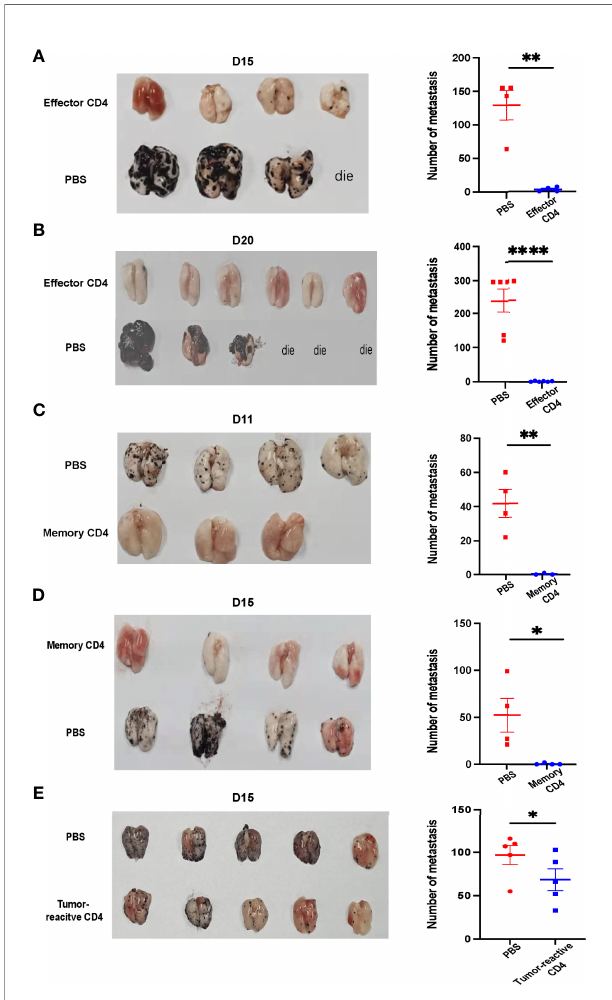
FIGURE 6 | Antigen-speci fi c effector CD4 + T cells can control lung metastasis while memory CD4 + T cells prevent mice from lung metastasis. (A, B) Image of lung samples of metastatic tumor models in which mice were inoculated with 5×10 5 B16-GP cells intravenously and 8 Days later transferred with 1×10 6 effector CD4 + T cells isolated from LCMV-Armstrong-infected mice. Tumor bearing mice were sacri fi ced on Day 15 (A) or Day 20 (B) after B16-GP inoculation. (n=4/group on Day 15, n=6/group on Day 20). Before Day 15, a mouse died and three mice died before Day 20. The statistical analyses of the metastatic foci are shown beside. (C, D) Image of lung samples of metastatic tumor models in which naïve mice were transferred with 1×10